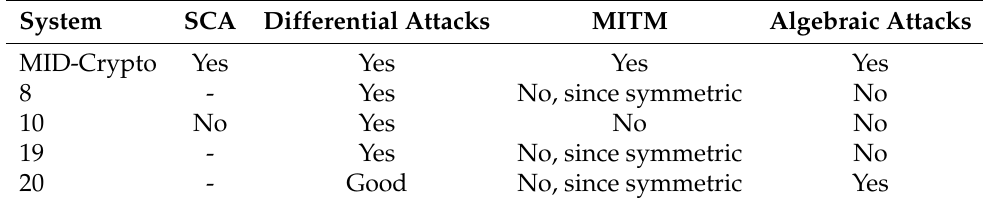
Table 7. Security Measures Compared with Other